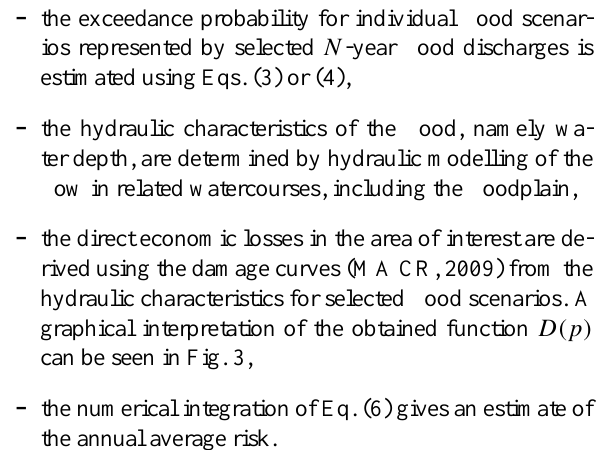
Fig. 4. Flow chart for the evaluation of potential flood loss using